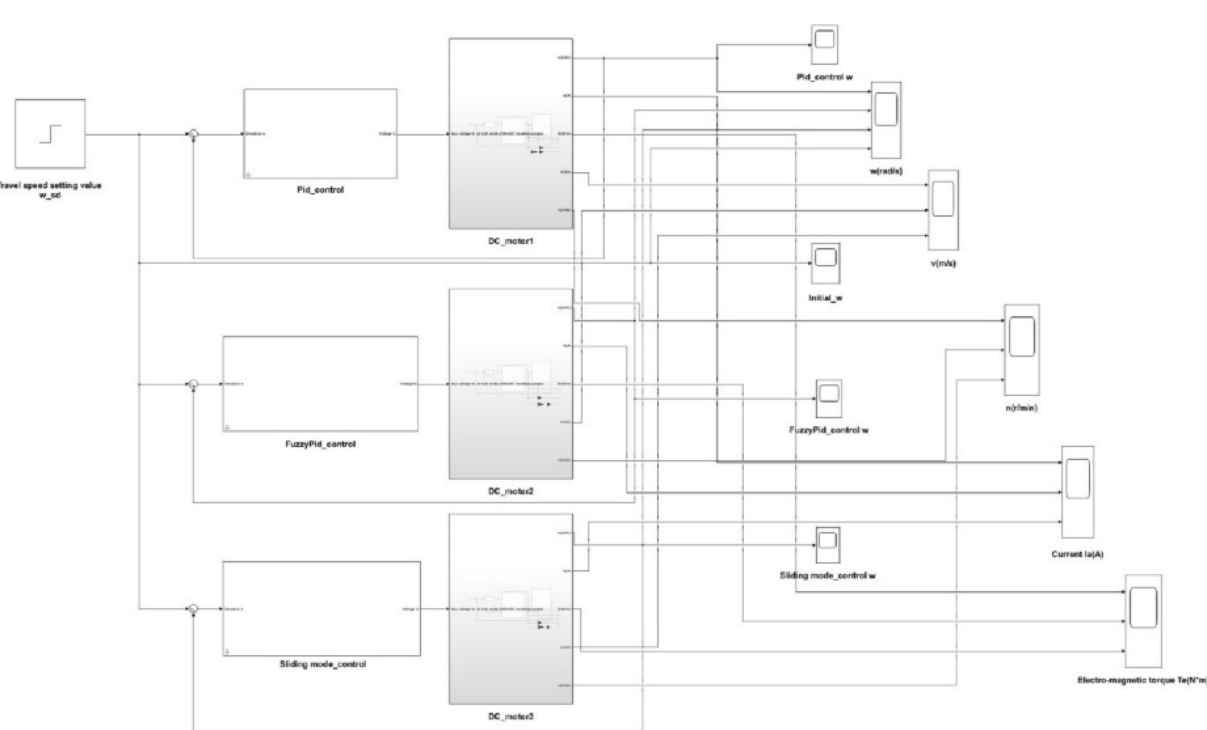
Figure 11. Simulink model of sliding mode control strategy.